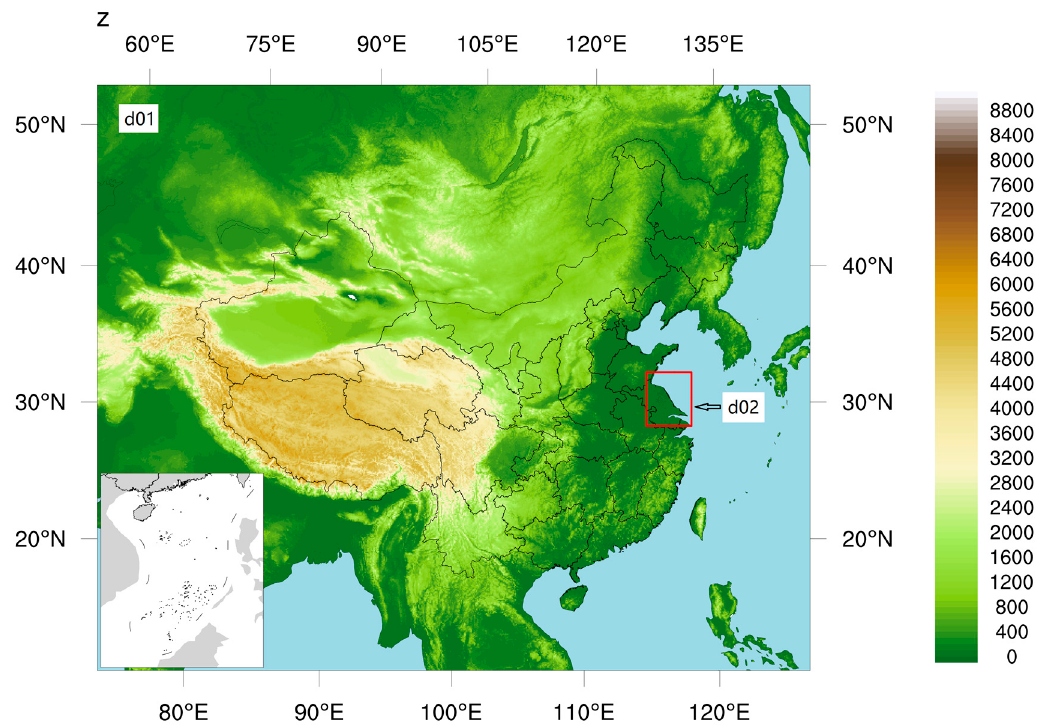
Figure 1. Nested grid of WRF models. The d01 grid contains most of China and the d02 grid contains the area of wind towers.